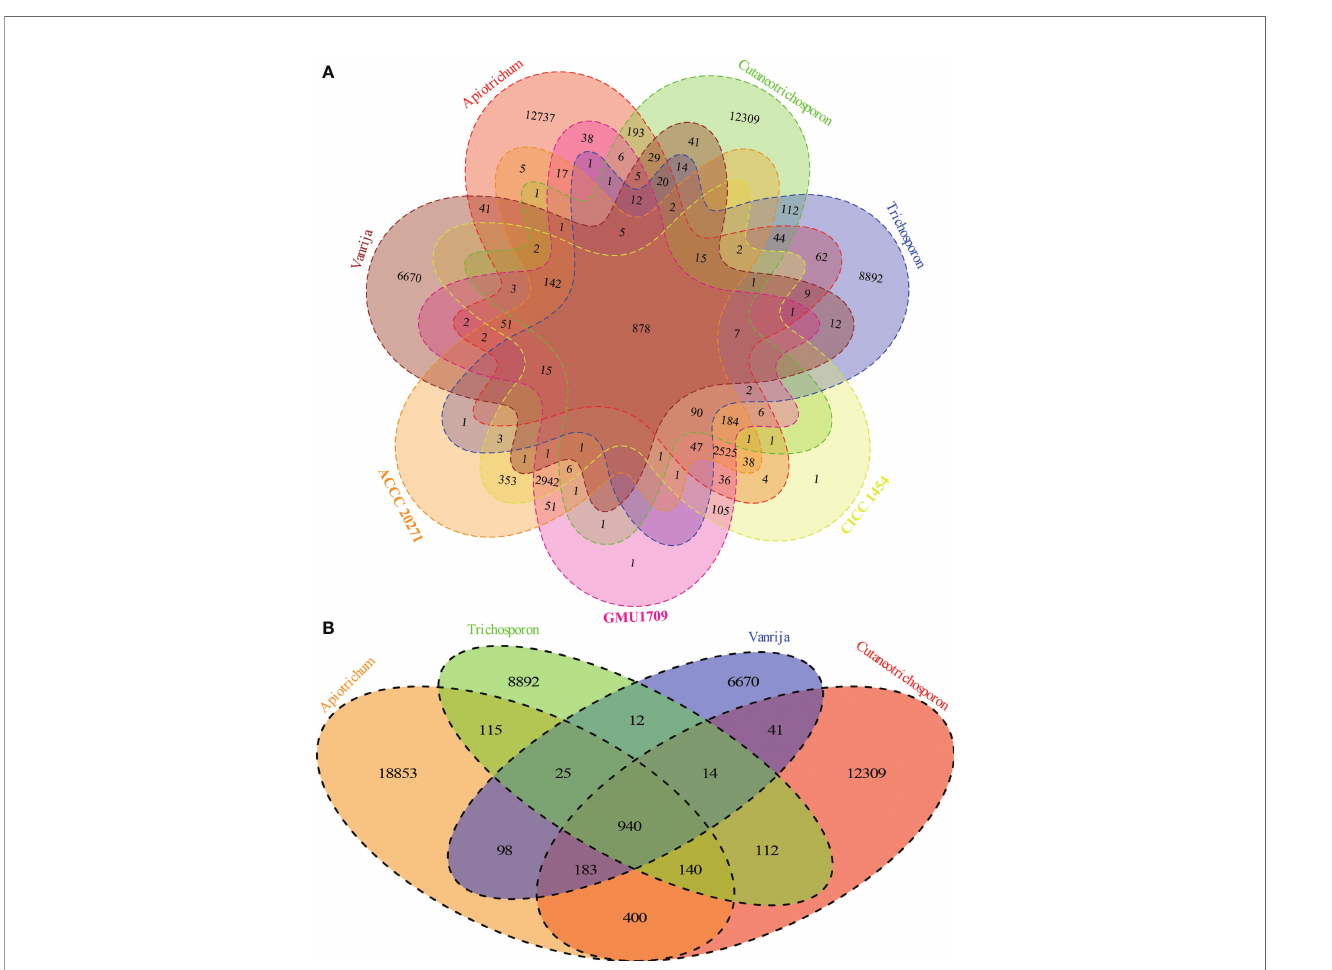
FIGURE 3 | Relationships among A. mycotoxinivorans strains and different Trichosporonaceae genera based on 48804 orthologous groups. (A) Venn diagram presents the relationships between three A. mycotoxinivorans strains and four Trichosporonaceae genera. A. mycotoxinivorans is not included in Apiotrichum . (B) Venn diagram presents the relationships between four Trichosporonaceae